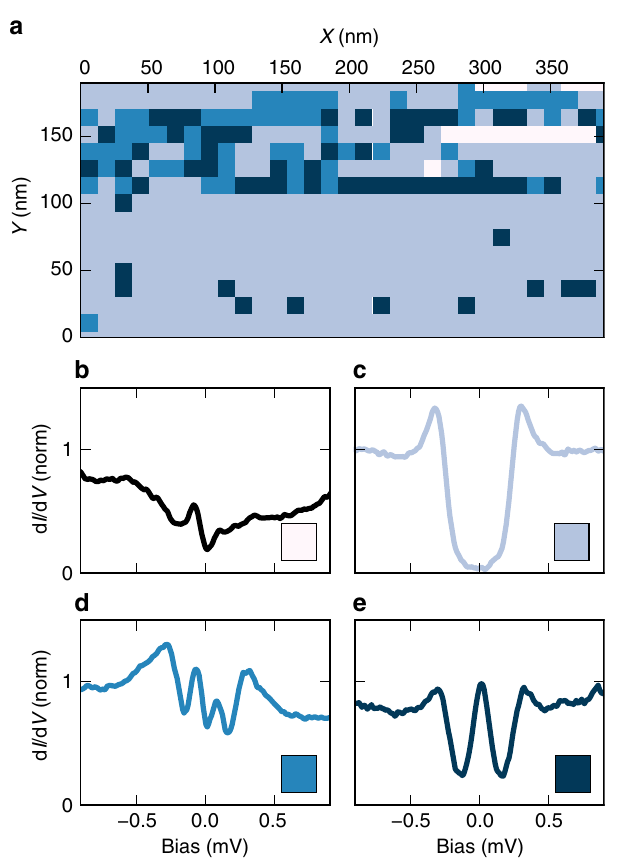
Fig. 3 Spatial dependence of the differential conductance. a Map of locations on the sample surface where different types of spectra shown in b – e have been observed. The different colours in a correspond to the different types of spectra observed and match the spectra shown in b – e . The shape of the spectra changes on length scales corresponding to the grain size of the EuS fi lms (8 – 18nm) 37 . Data were recorded on sample